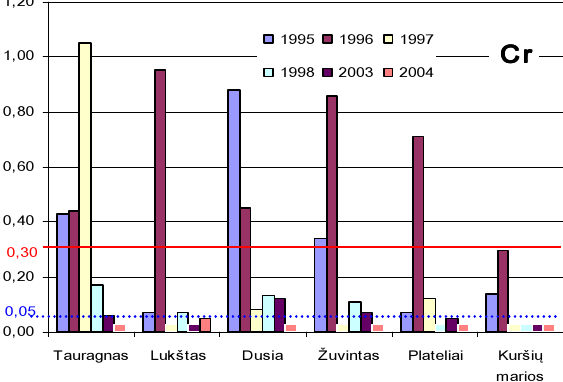
Fig. 9. Heavy metal concentrations (mg/kg) in fish tissues from water contaminated with chromium in 2005